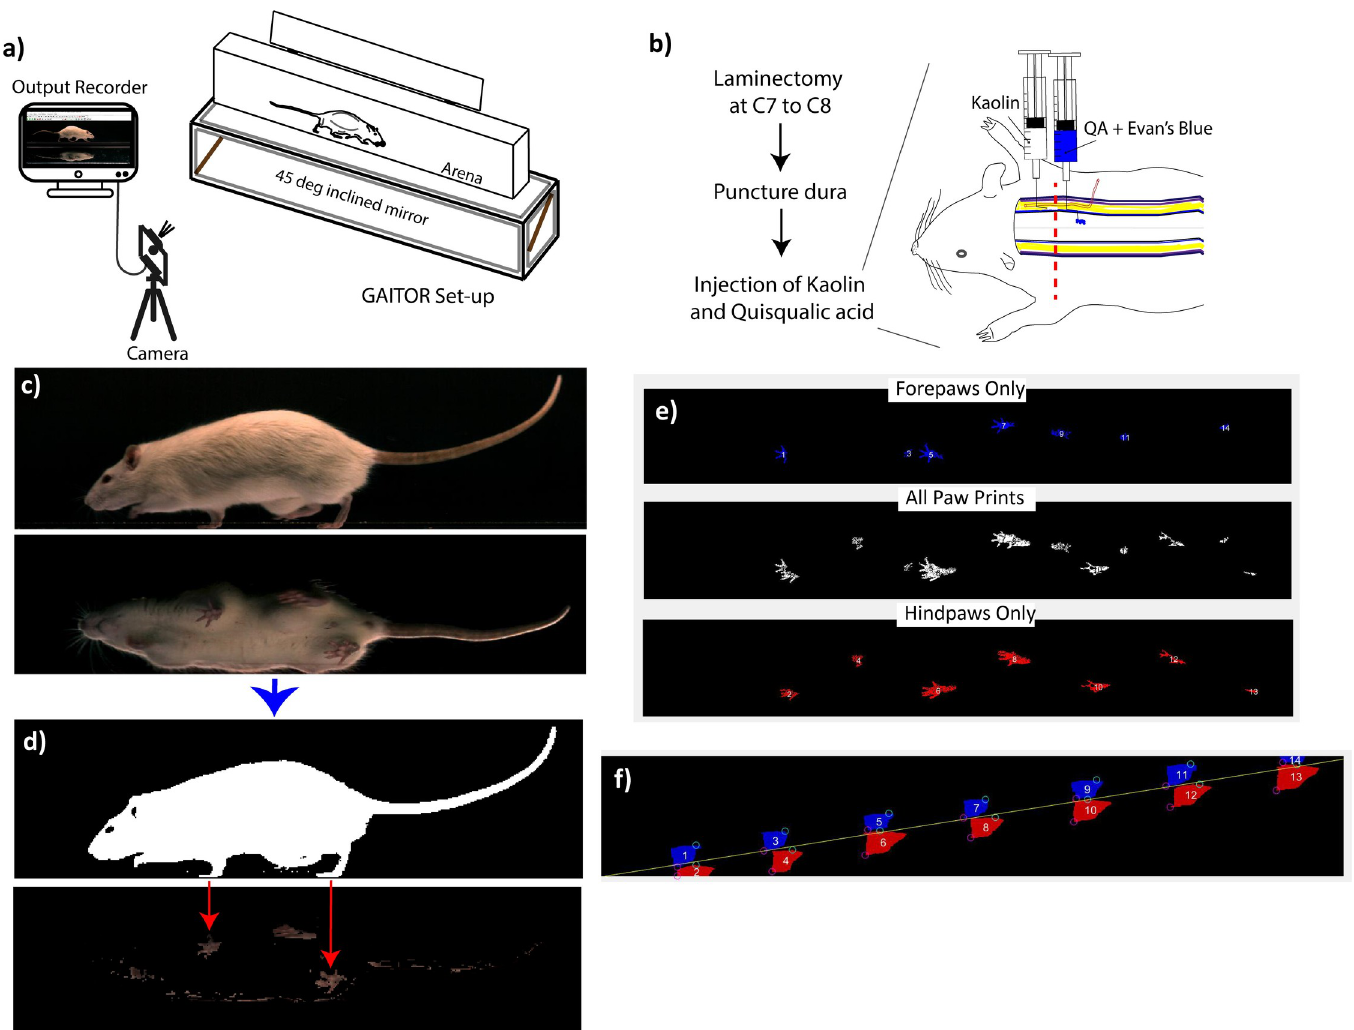
Fig 1. GAITOR set up, injury model, and overview of GAITOR analysis. a) Schematic representation of GAITOR reproduced with permission from the publisher from [22]. b) Schematic representation of the PTSM injury at the C7- T1 level of the spinal cord, which potentially impacts forelimb as well as hindlimb movement, to some extent, by forming syrinxes in the spinal cord. c) A representative frame of a GAITOR video showing a sagittal and ventral view of the rat. d) AGATHA software filters rat and paws from the background in the sagittal and ventral view, respectively. e) Pawprint images of forepaws, hind paws, and combined as generated for each video. f) Plots of forepaws (blue) and hind paws (red) showing foot stride (green circle) and toe-off (pink circle) generated for every